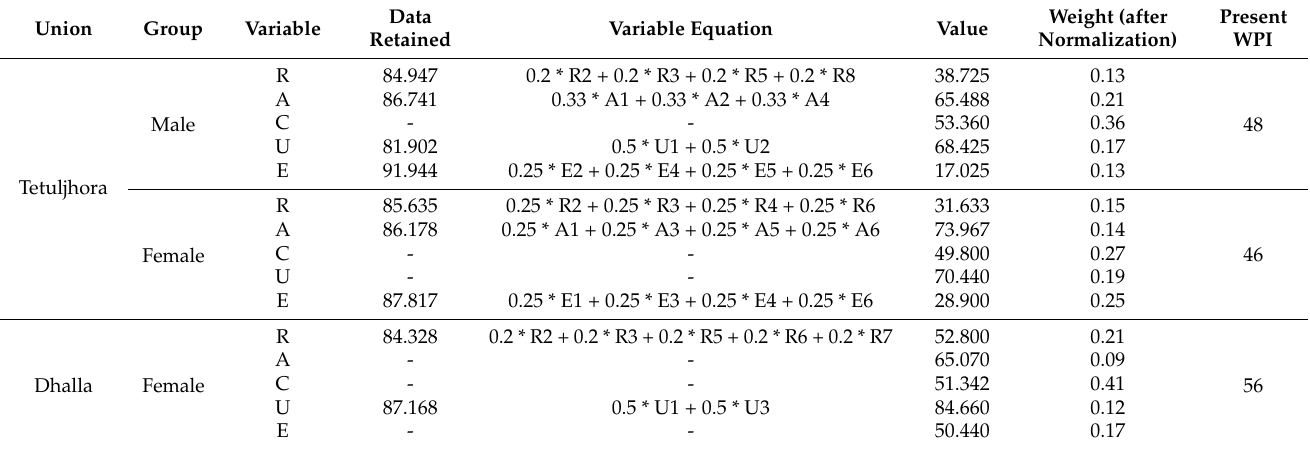
Table 3. PCA results for industrial workers in peri-urban areas around Dhaka.